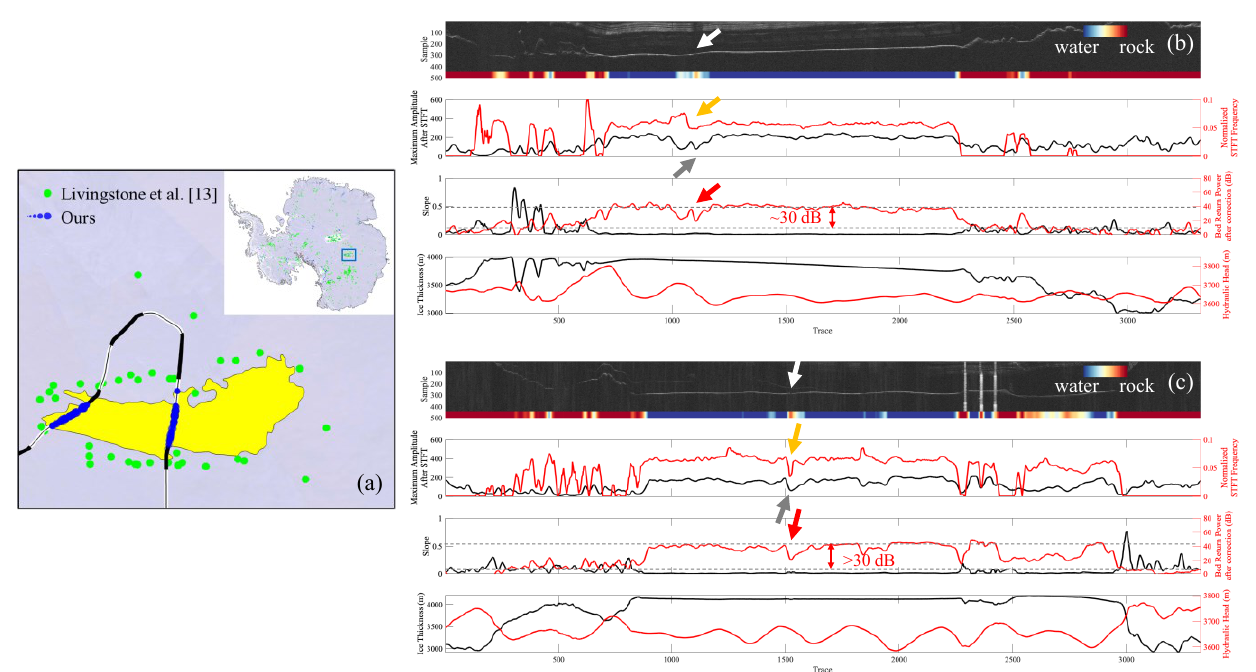
Figure 9. ( a ) The comparison of results of the subglacial water bodies near Lake Vostok, whose region in yellow is redrawn according to [57]. The green dots represent the inventoried subglacial lakes by Livingstone et al. [13], and the blue dots represent subglacial lakes calculated by our method; the size of the dots represents the probability of a subglacial water body. ( b,c ) The detection and identification results of basal materials for different radar profiles. ( b ) The B-scope stitched together by radargram frame 20131127_01_039 and frame 20131127_01_040. ( c ) The B-scope stitched together by radargram frame 20131127_01_045 frame 20131127_01_046.